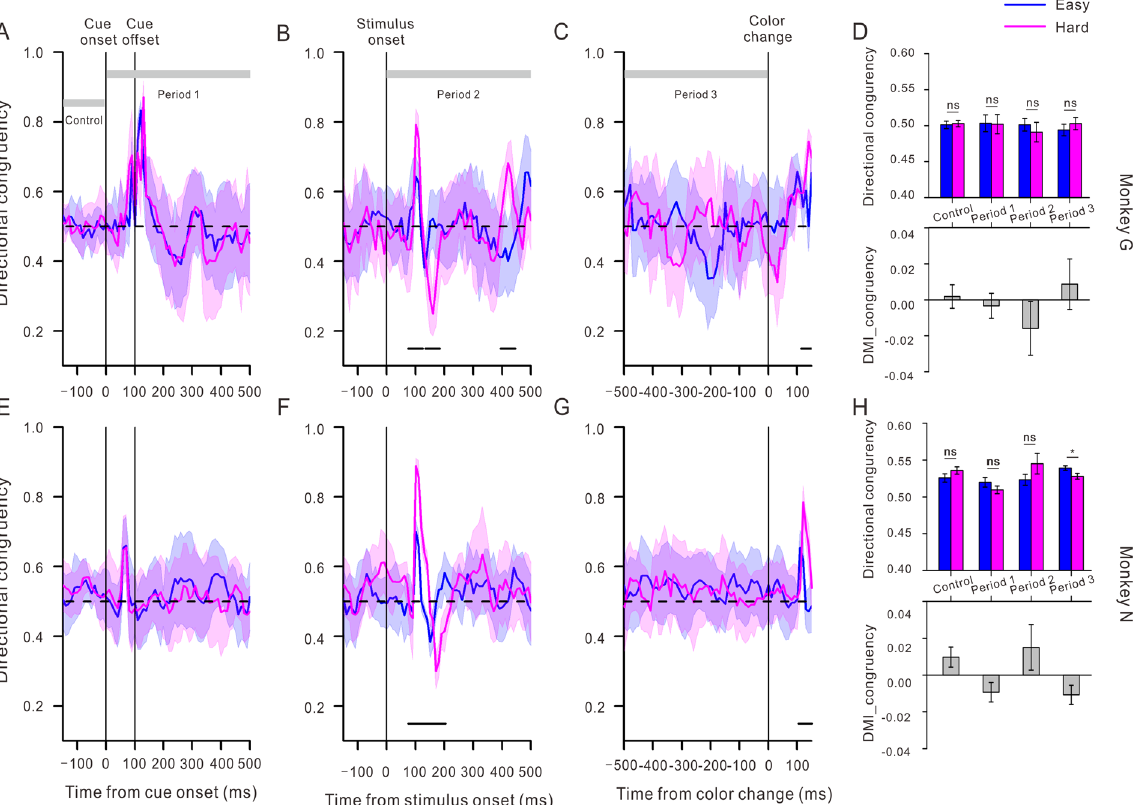
Figure 4. The temporal dynamics of the microsaccade directional congruency and the modulations of perceptual load on the microsaccade directional congruency during different time periods. ( A – C , E – G ) Temporal comparison of the directional congruency ratios between the easy (blue) and hard (pink) tasks for monkeys G and N. The horizontal black dashed lines represent a y -axis value of 0.5 and indicate no microsaccade directional bias toward the indicated location. The black lines at the bottom of each plot denote the periods in which the directional congruency from the easy and hard tasks differed significantly ( p < 0.05, Student t test). The gray rectangles are defined as in earlier figures. ( D , H ) Measures of the perceptual load modulation on the overall congruency of the microsaccade direction during the four periods. The top panels depict the average directional congruency in the easy (blue) and hard (pink) tasks during the four periods. The bottom panels demonstrate the DMI ratios of the direction congruency within the four time periods. The figure conventions are the same as the previous